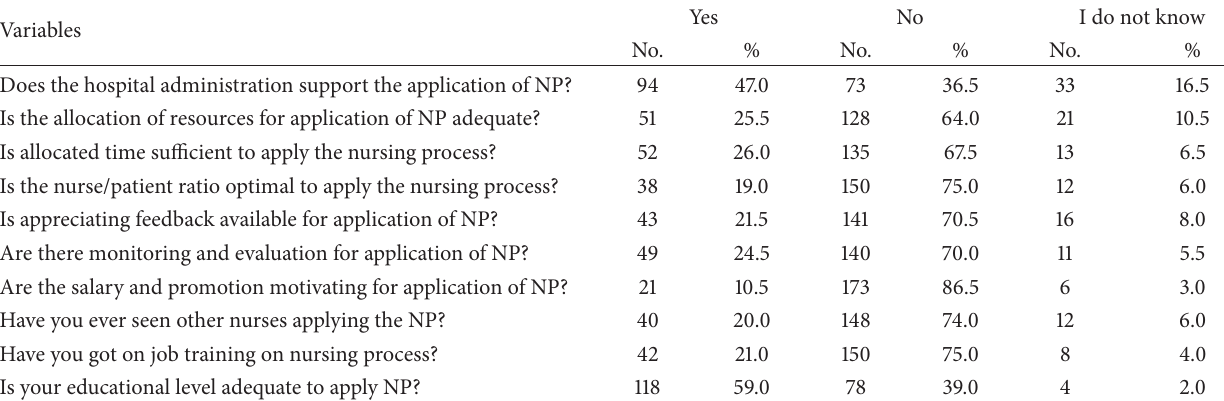
Table 5: Enabling and reinforcing factors for the application of nursing process by the nurses of Mekelle Zone Hospitals, northern Ethiopia, March 2011 ( 𝑛 = 200